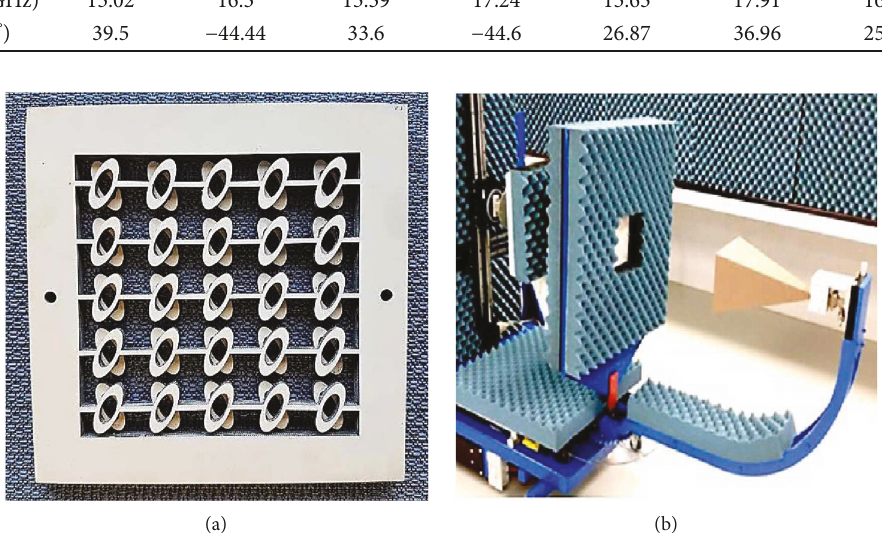
Figure 4: Photos of the realized prototype (a) and measurement setup